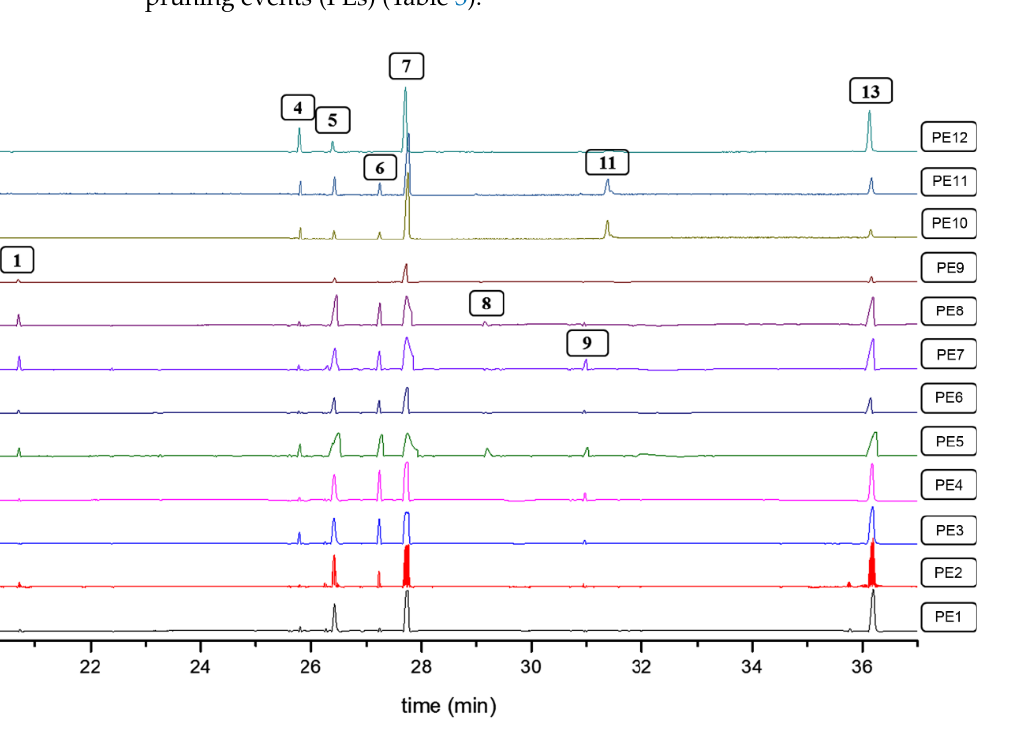
Figure 5. Stacked GC-MS chromatograms of quinolizidine-rich extract (QRE), obtained after pruning events (PE1–12) on L. polyphyllus . The box-enclosed numbers represent each identified quinolizidines, listed in Table 1. PE = pruning event.